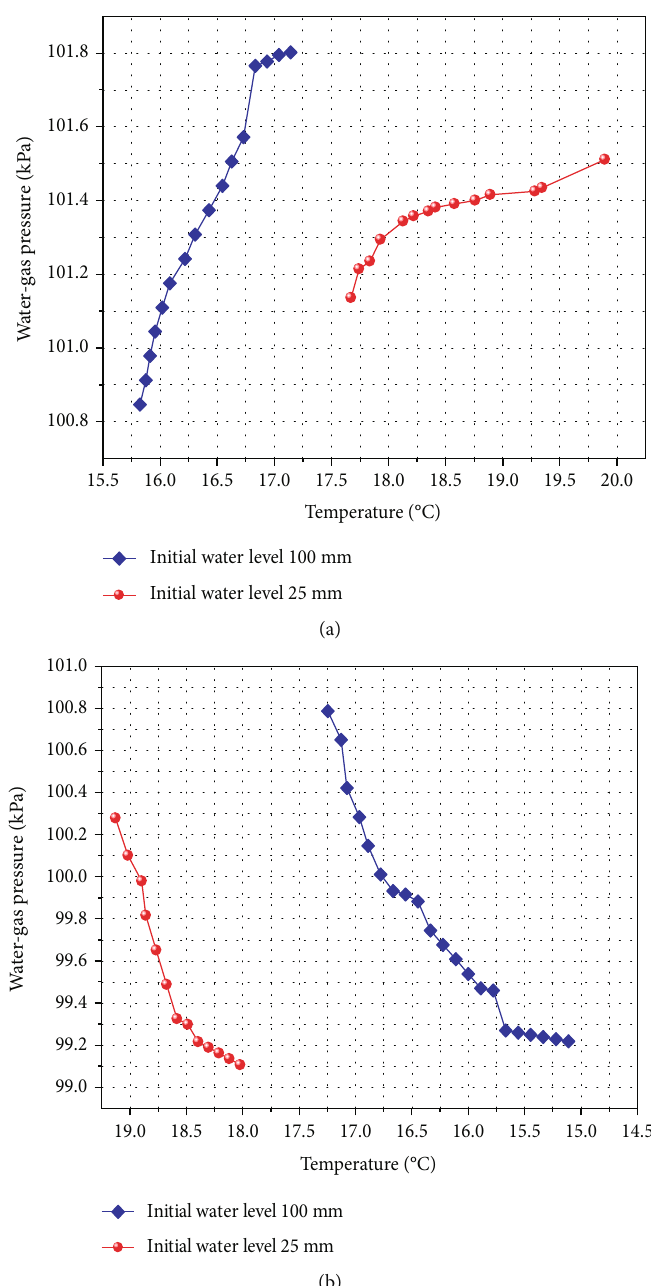
Figure 6: Relationship between water-gas pressure and temperature during water level rise and fall when collapse. (a) Water level rise. (b) Water level